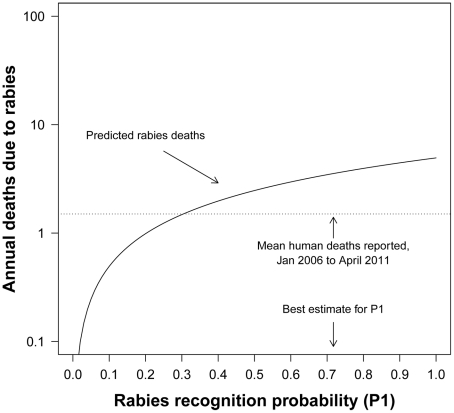
Predicted annual human deaths from rabies.Deaths are predicted in Phuentsholing and Gelephu areas of south Bhutan in relation to rabies recognition probability (P1) and mean number of human rabies deaths reported, adapted from Cleaveland et al., 2002 (reference number 11).